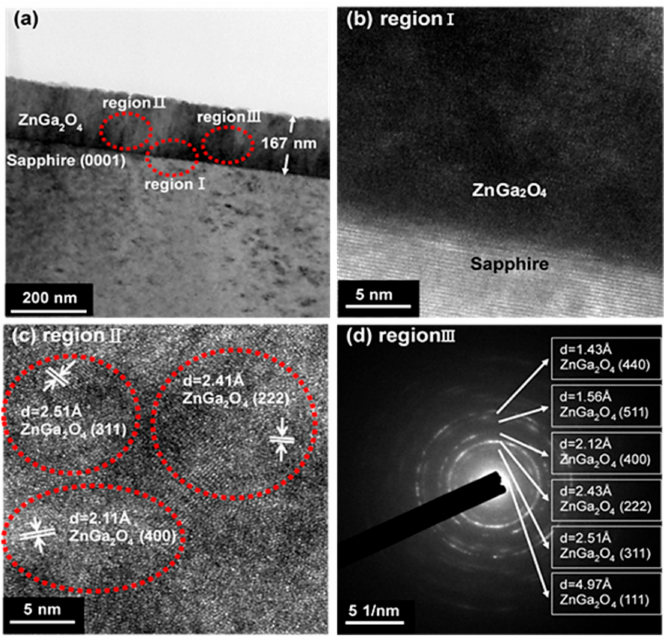
Figure 4. ( a ) Cross-sectional TEM image of the ZnGa 2 O 4 / sapphire sample. HRTEM images focused on ( b ) region I, ( c ) region II, and ( d ) region